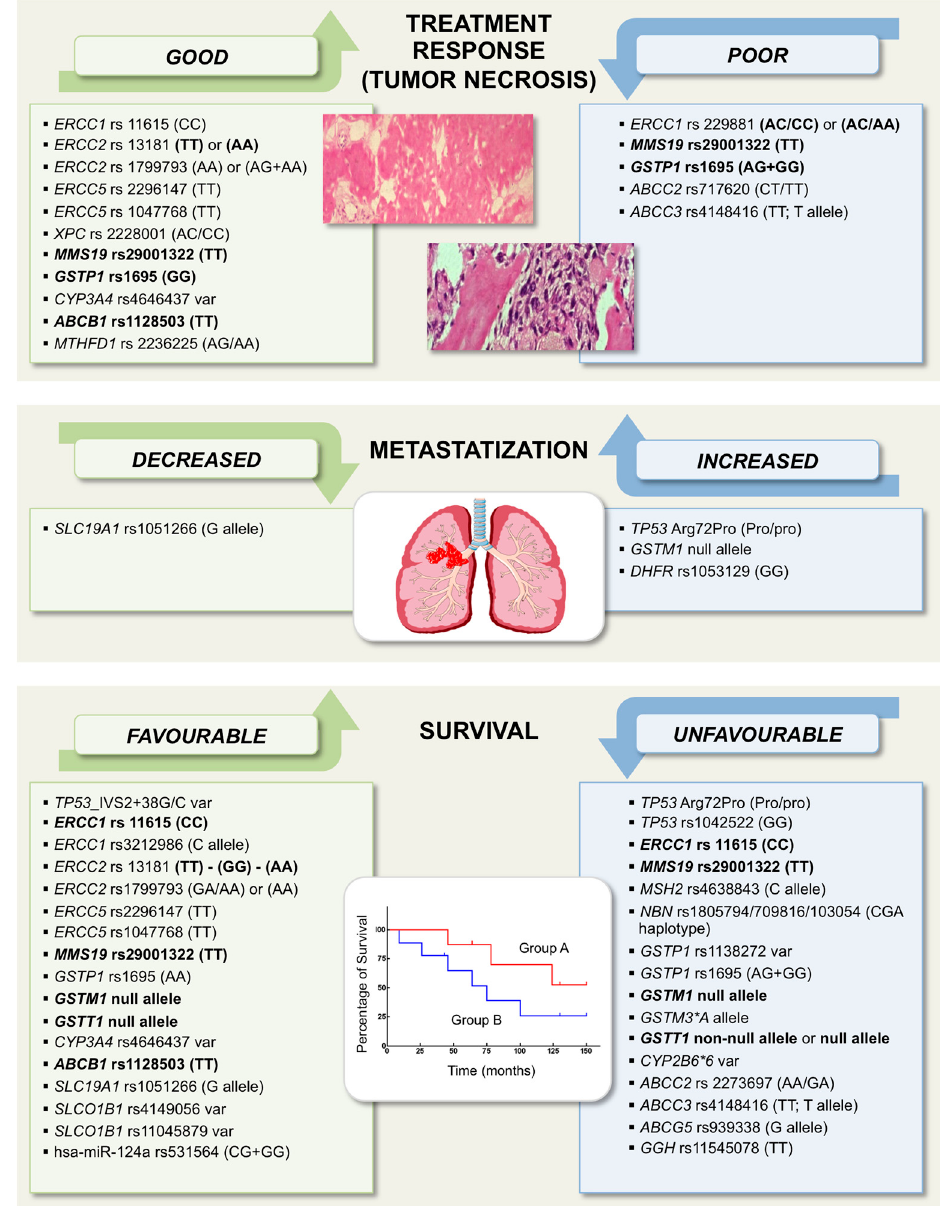
Figure 1. Pharmacogenetic and pharmacogenomic variations impacting on treatment response, outcome and prognosis in high-grade osteosarcoma (HGOS). Genes, polymorphisms and corresponding genotypes (inside parenthesis) are listed inside each box. Genotypes have been reported as they were described in the original studies. Gene polymorphisms or genotypes for which contradictory results have been reported are marked in bold. Genes polymorphisms included in the green boxes (left side) are those which have been indicated to favorably impact on patients’ outcome. Further details, abbreviations legend and references are provided in the text.